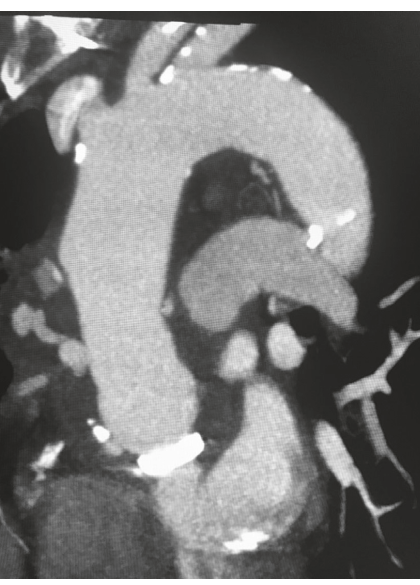
Figure 1: CTA showing pseudoaneurysmal degeneration of the aortic graft with fistulous flow to the right upper lobe.